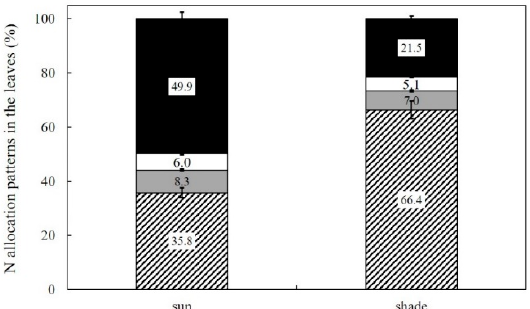
Figure 6. N allocation patterns in sun and shade leaves (%) of Robinia pseudoacacia . The black part of the column denotes N allocated to RuBisCo (N R ); the white portion denotes N allocated to the light-harvesting complex (LHC), PSI and PSII (N L ); the dark-gray part denotes N allocated to electron transport proteins (N E ), and the diagonally hatched box denotes the rest. Values represent mean ± SE.